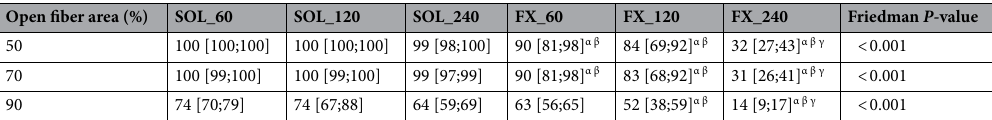
Table 2. Percentage of open fibers in the six test sessions ( n = 10) for the thresholds of 50, 70 and 90% open fiber area. median [25pct;75pct]; SOL: Solacea; FX: FX800 CorDiax; _60: dialysis of 60 min; _120: dialysis of 120 min; _240: dialysis of 240 min. α P < 0.05 versus SOL_60; β P < 0.05 versus SOL_120; γ P < 0.05 versus SOL_240.